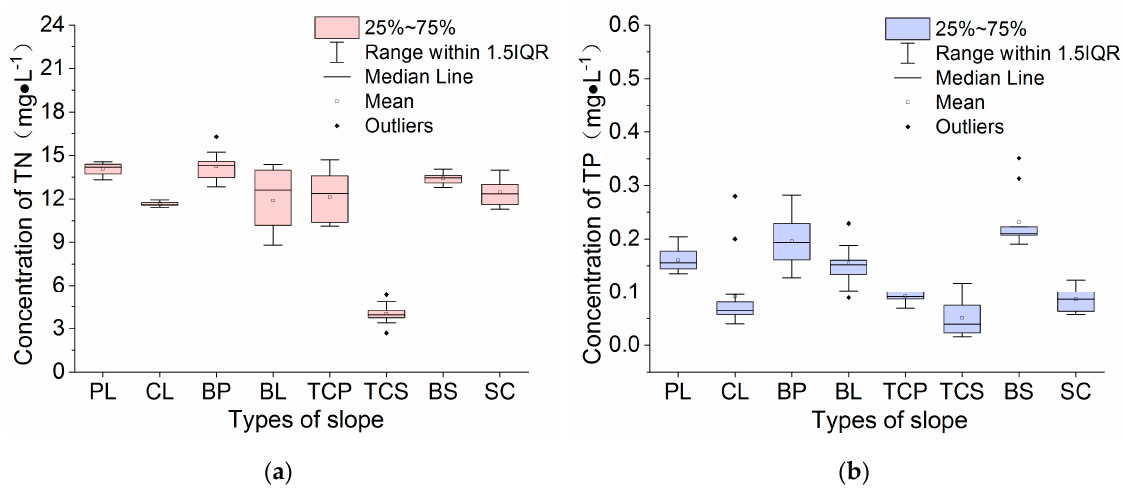
Figure 8. The average concentration of TN ( a ) and TP ( b ) with different slope treatments.